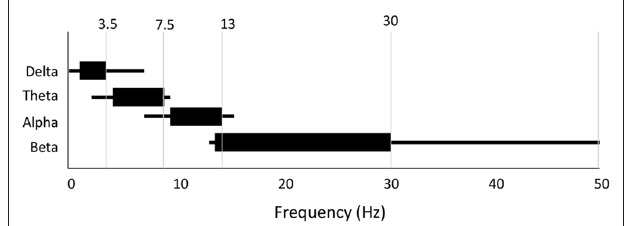
FIGURE 8 | Variability in frequency band definition. Range of frequencies used for each band across all 184 studies. Thick line indicates most commonly used